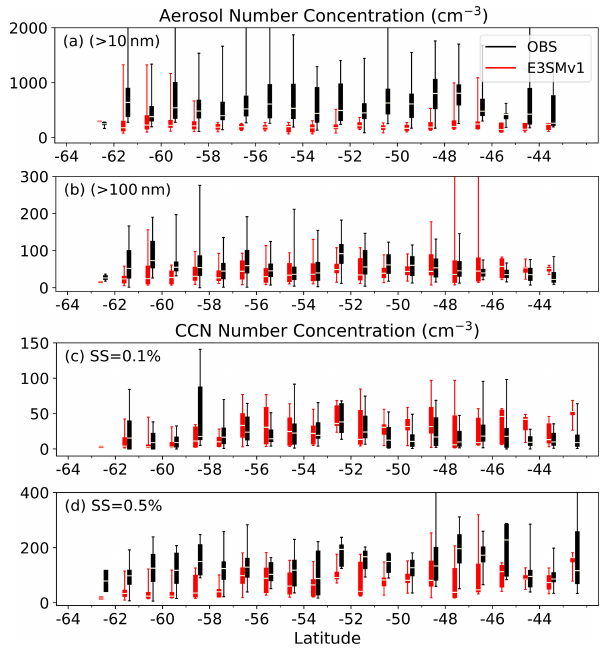
Figure 17. Percentiles of (a) aerosol number concentration for di- ameters > 10nm, (b) aerosol number concentration for diameters > 100nm, (c) CCN number concentration for SS = 0 . 1%, and (d) CCN number concentration for SS = 0 . 5% for all aircraft measure- ments between 0 and 3km in SOCRATES binned by 1 ◦ latitude